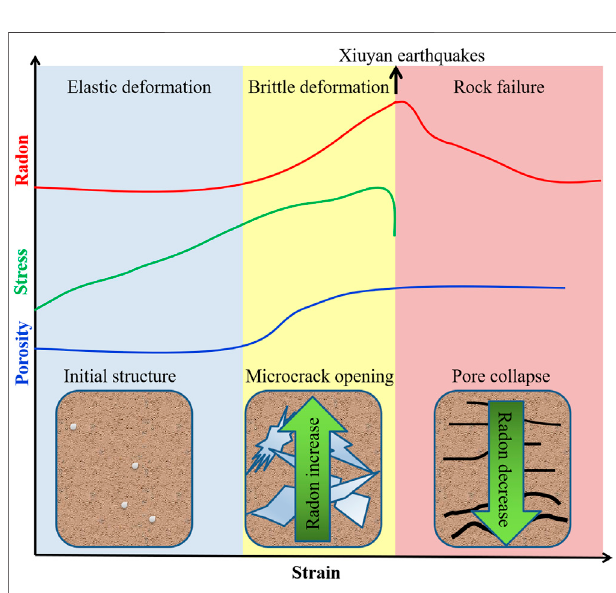
FIGURE 6 | Simpli fi ed sketch illustrating the model of radon concentration change caused by the Xiuyan earthquakes.